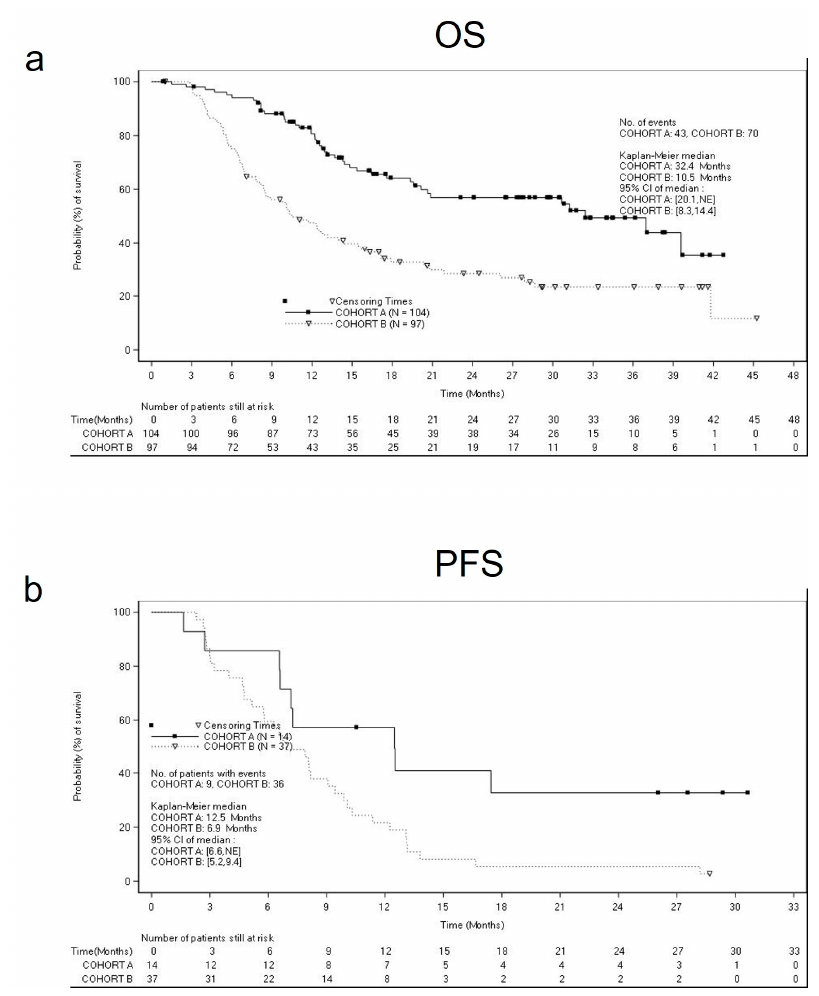
Figure 2. Kaplan–Meier estimates of overall survival ( a ) and progression-free survival ( b ) in the cohorts . Panel ( a ) shows the median overall survival in cohort A (32.4 months) and cohort B (10.5 months). Panel ( b ) shows the median progression-free survival in cohort A (12.5 months, with 9 events occurred) and cohort B (6.9 months, with 36 events occurred).